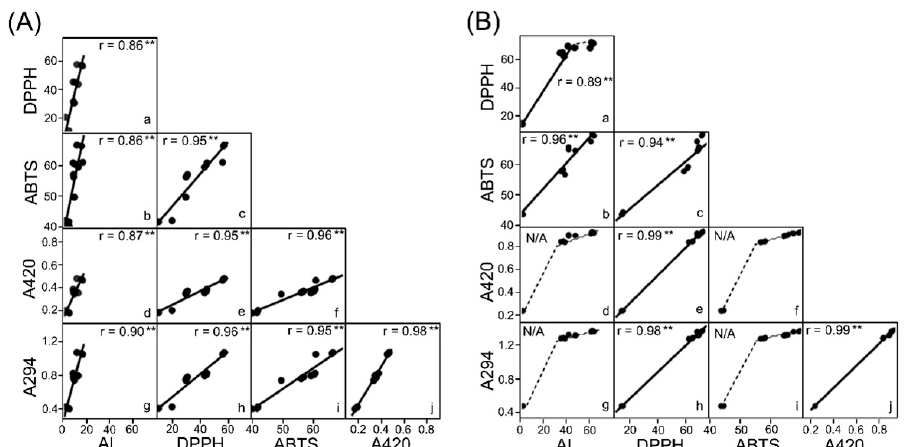
Figure 4. Relationship between antioxidant activities and Maillard reaction indicators in glycated collagens. Each box column presenting a bivariate scatterplot indicates mutual relationships between DPPH radical scavenging activity (DPPH), ABTS radical scavenging activity (ABTS), browning intensity (A420), the intermediate-stage indicator (A294), and available lysine loss (AL). Figures ( A , B ) present C-AO and C-Glu results, respectively. The numbers in the scatterplot also show the correlation coefficients (**: p < 0.01).